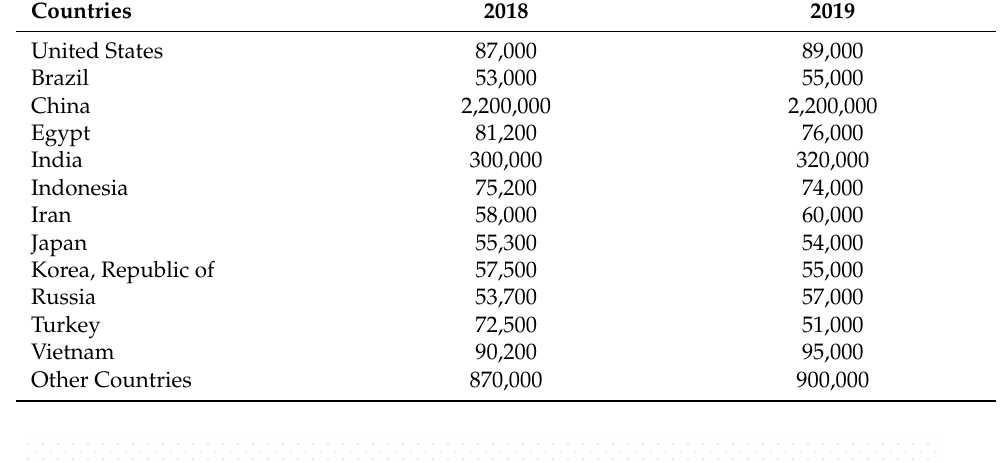
120CalabarKwaraYandevNkalaguSokotoIgumaleMakurdiEwekoro